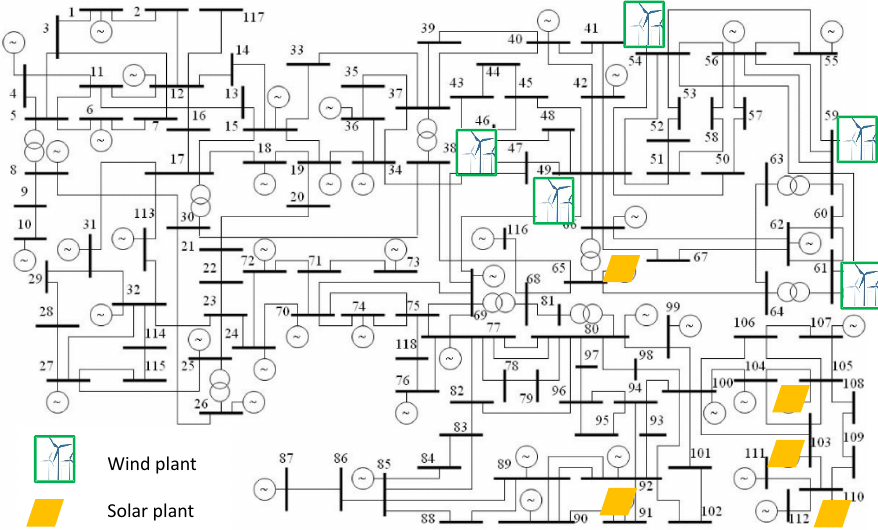
Figure 1. IEEE 118 bus system one line diagram with a focus on the buses where RES plants are located